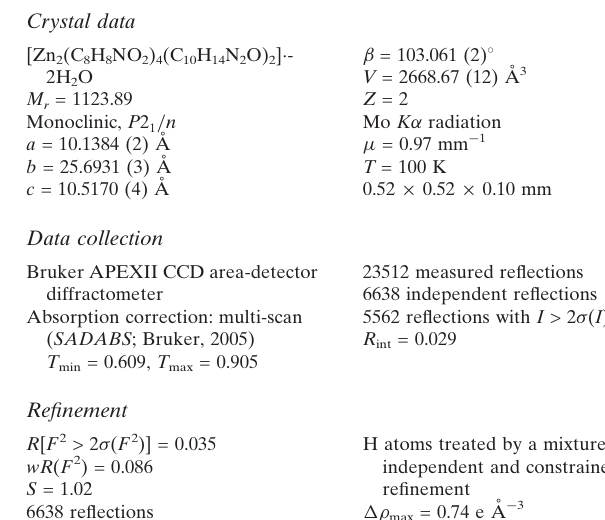
Data collection Bruker APEXII CCD area-detector diffractometer